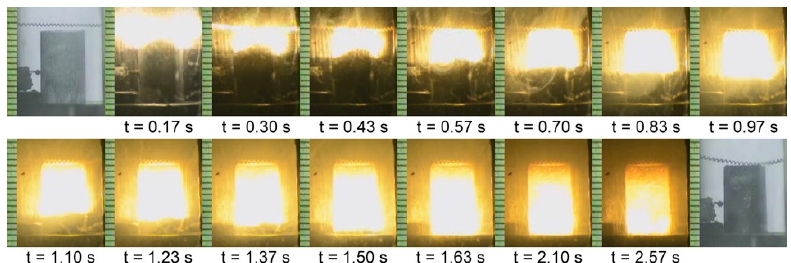
Figure 1. Typical sequence of self-sustaining combustion images recorded from Reaction (2) with y = 1.4.